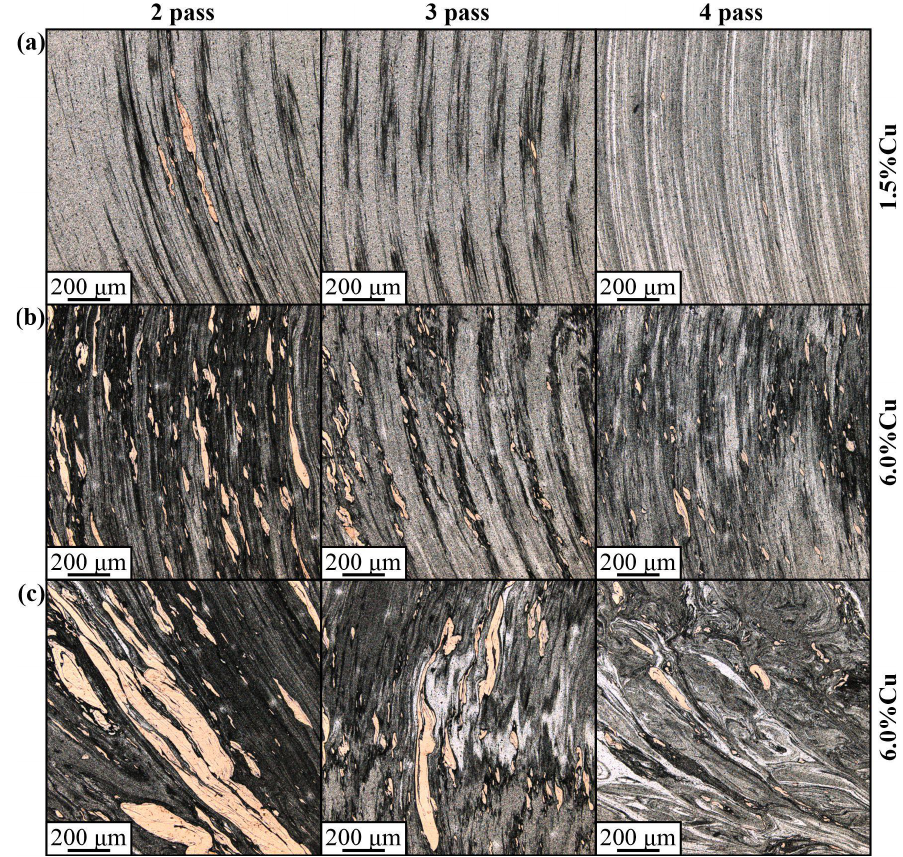
Figure 11. The macrostructures of horizontal plane section in samples containing 1.5 vol.% Cu ( a ) and 6.0 vol.% Cu ( b , c ). The macrostructures of intensively stirred zone ( b ) and stagnant zone ( c ). Apart from pure mechanical breaking of the large compacted particles, there may be plastic deformation, as well as simultaneous diffusion of copper into aluminum. The ther- momechanical conditions of stirring such as plastic deformation rate and temperature also have an effect on the diffusion of copper into aluminum, as well as on IMC formation. The TEM images make it possible to observe the detailed structure of Al-Cu interme- tallic particles formed in the stir zones of samples, particularly those with 1.5 vol.%Cu containing dynamically recrystallized α -Al(Cu) grains with sizes in the range of 0.67 – 4.21 μm an d a mean size of 1.86 ± 0.6 m (Figure 12a). The dark-field images in Figure 12c,d obtained using α -Al (3 – 1-1) reflection in the SAED pattern (Figure 12b) show coarse α -Al(Cu) grain with dislocations (Figure 12c). Apart from the α -Al grains, there are reflections iden- tified as those of β -Al 3 Mg 2 IMC (Figure 12b,d) and S-phase (Al 2 CuMg) (Figure 12e – g).